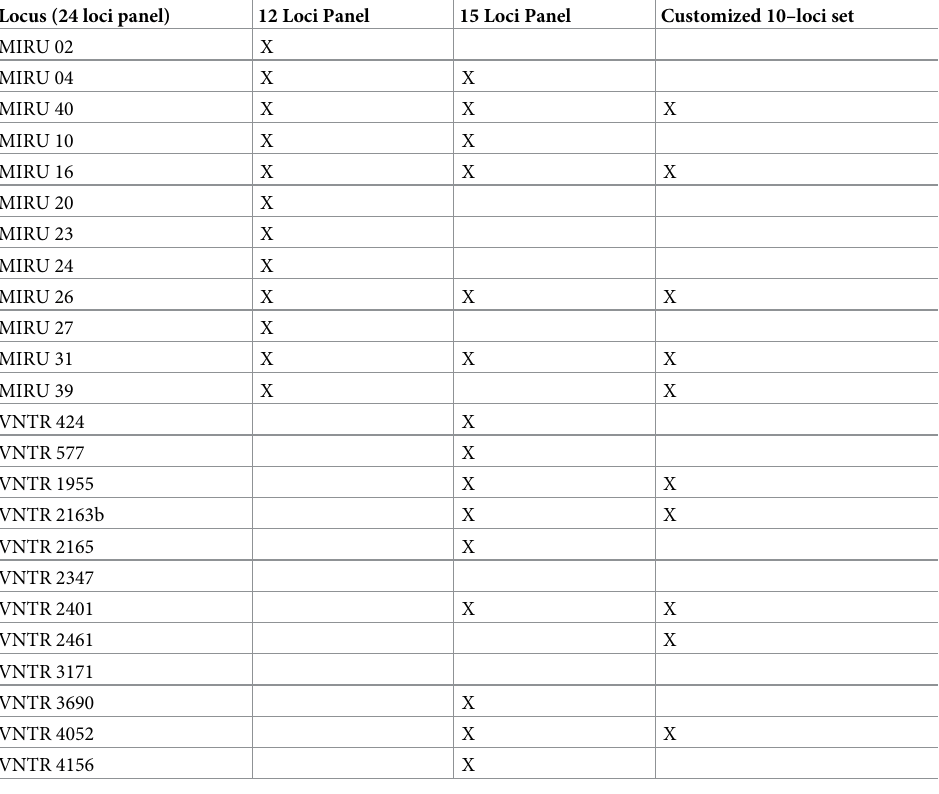
Table 1. MIRU-VNTR 24 loci set with individual HGDI and inclusion in standardized and customized genotyp- ing panel. Locus (24 loci